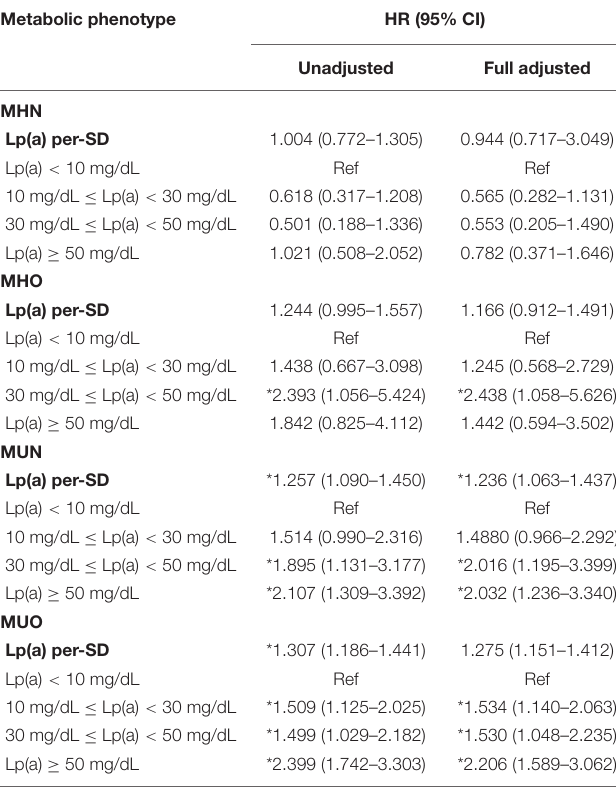
TABLE 2 | Lipoprotein(a) [Lp(a)] and cardiovascular events (CVEs) in different metabolic status. Metabolic